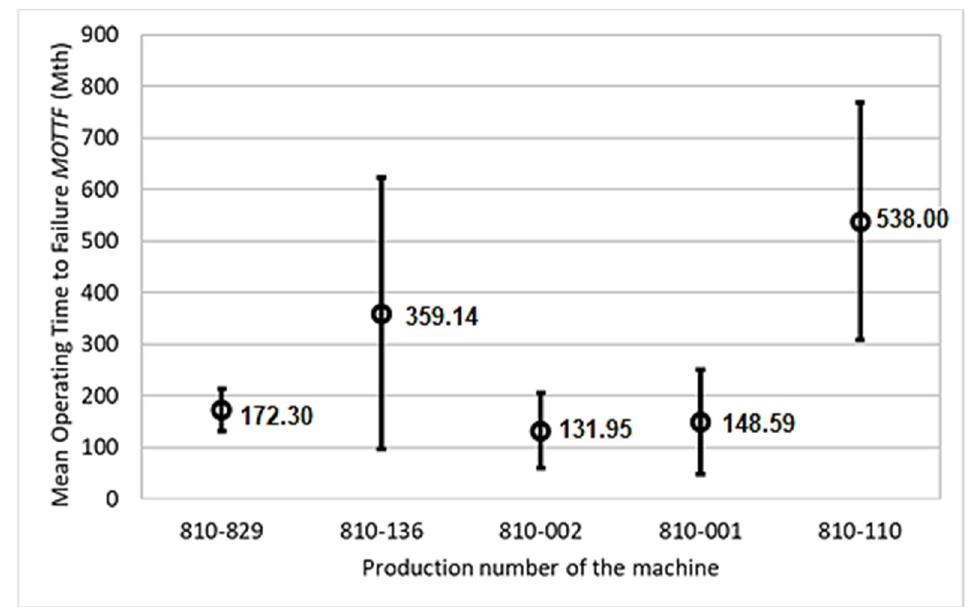
Figure 1 Graph for 95% confidence intervals of reliability for mean operating time to failure for individual forwarders.